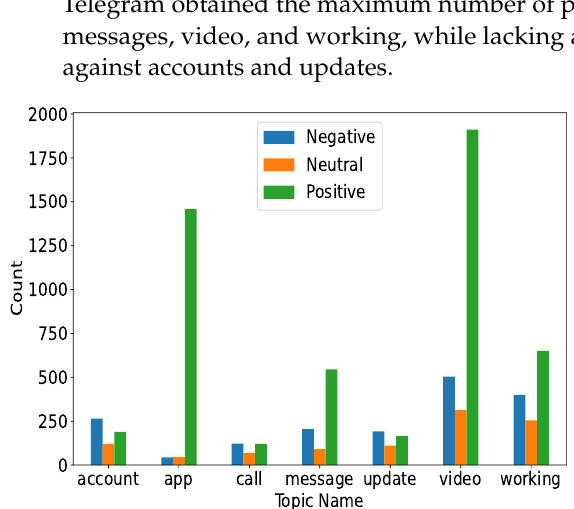
Figure 11. Sentiments on